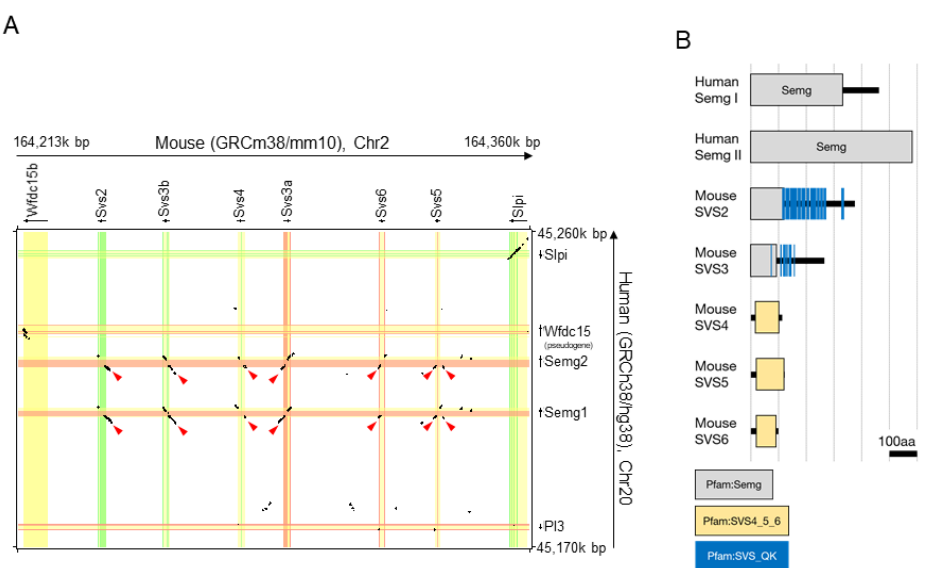
Figure 1. Comparative analysis of the mouse and human seminal proteins. ( A ) Dot-plot display of the mouse genome, including Svs2-6 ( x -axis), and the human genome, including SemgI and II ( y -axis). Nucleotide positions are indicated for the mouse sequence on the x -axis, and sequence identity with the corresponding human sequence (50–100%) is shown as black dots. Shading in orange and green indicates the locations of exons on the + and – strands, respectively. Yellow areas represent introns. Red arrow heads indicate that the human SemgI and II share gene similarities with mouse Svs2-6 . ( B ) Domain architectures of the human SEMGI and II and the mouse SVS2–6. SEMGI and II, as well as SVS2 and 3 share a SEMG domain (gray box). SVS4–6 share other domains (yellow box).